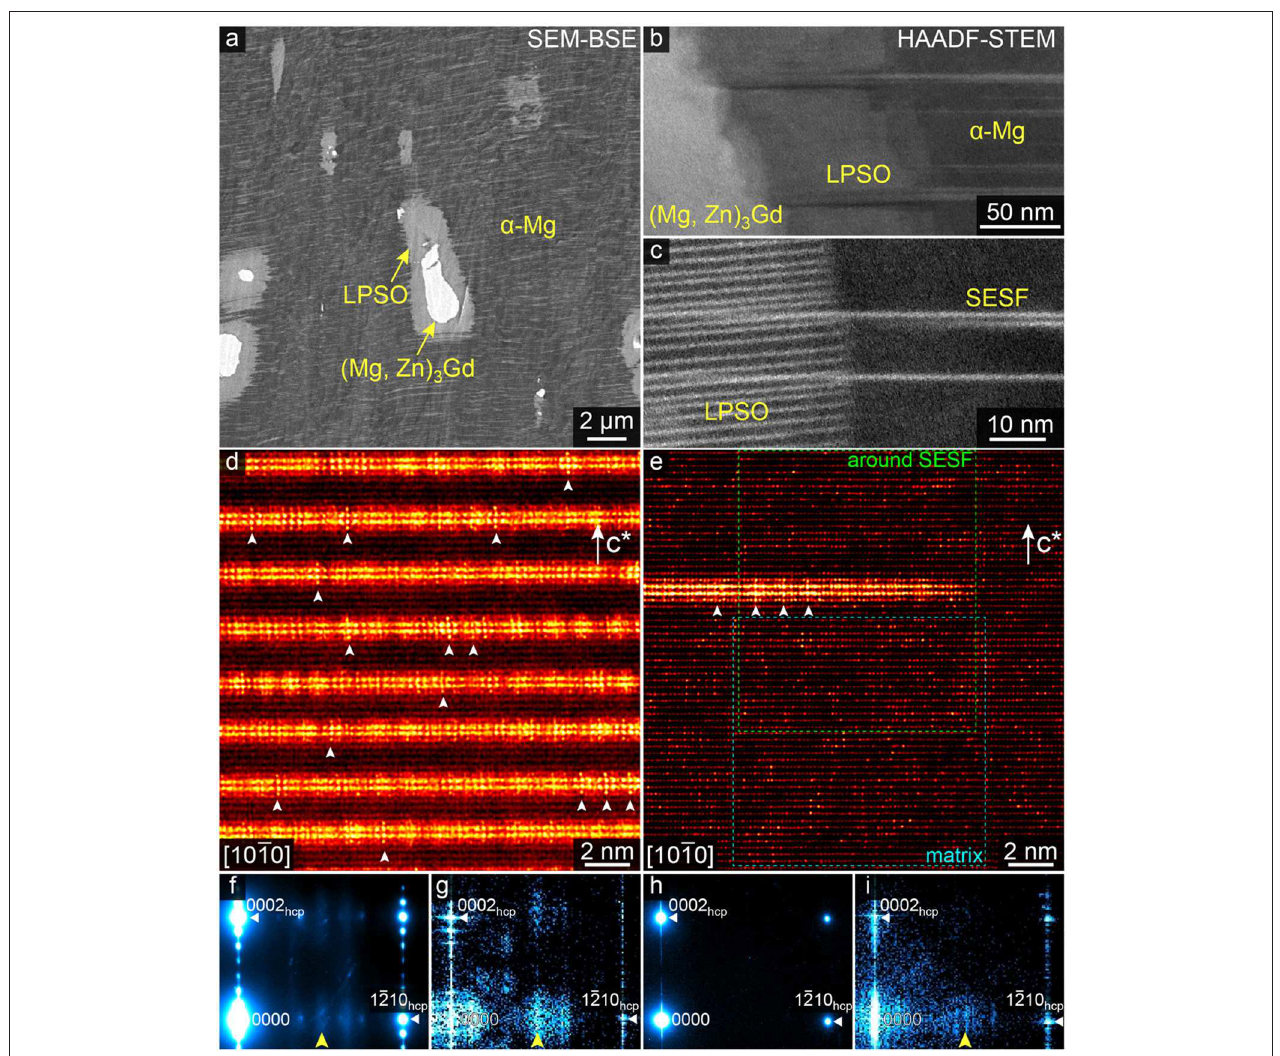
FIGURE 1 | (a) SEM-BSE image taken from a heat-treated Mg 97 Zn 1 Gd 2 alloy. (b,c) HAADF-STEM images of the multiple-phase coexisting regions of the (Mg,Zn) 3 Gd compound, the LPSO phase and the α -Mg phase with essential SESFs. (d,e) Atomic-resolution HAADF-STEM images of the 14H-type LPSO phase and the α -Mg matrix along the [10 ¯ 10] hcp directions, respectively. c* denotes the c -axis of the matrix crystals. Blue and green dotted rectangles in (e) correspond to the enlarged areas shown in Figures 3a , 7a , respectively. (f) EDP and (g) PS calculated from the LPSO phase images of (d) , and (h,i) represent those for the α -Mg matrix image of (e) in the same manner, respectively. The indices of the major reflections in EDPs and PSs are given based on the hcp -Mg